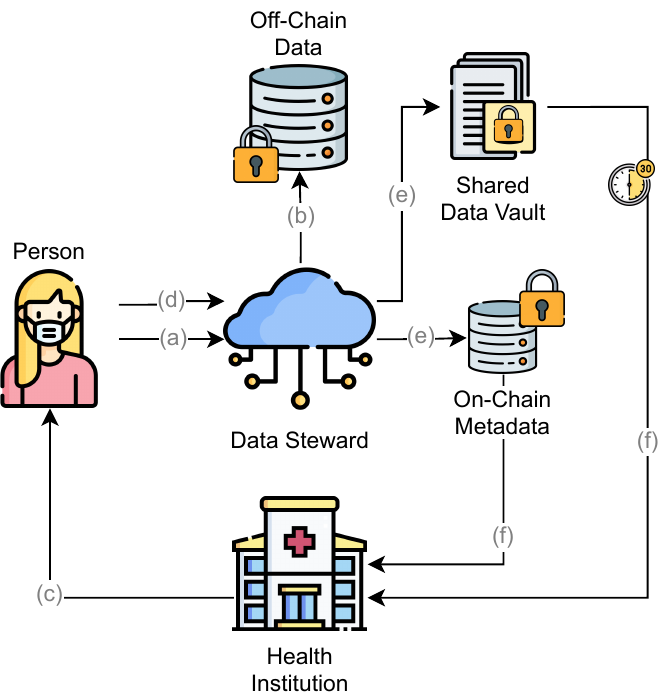
Figure 3. Data flow of the solution: The user sends authorization to the DS for a given consortium. Health institutions can send the data back to the DSs as